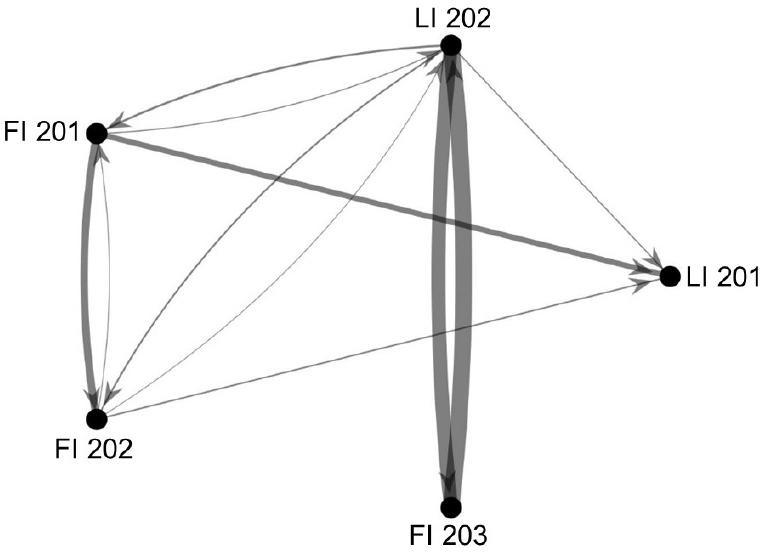
Figure 9. PS-PC1 PS (PS2) causality map, produced in the second stage of the hierarchical approach. The root cause is a faulty valve located on line FI 203. Edge weights represent magnitude of causal influence (measured by the G-causality index defined in Section 2.1). LI, level indicator; FI, flow indicator.